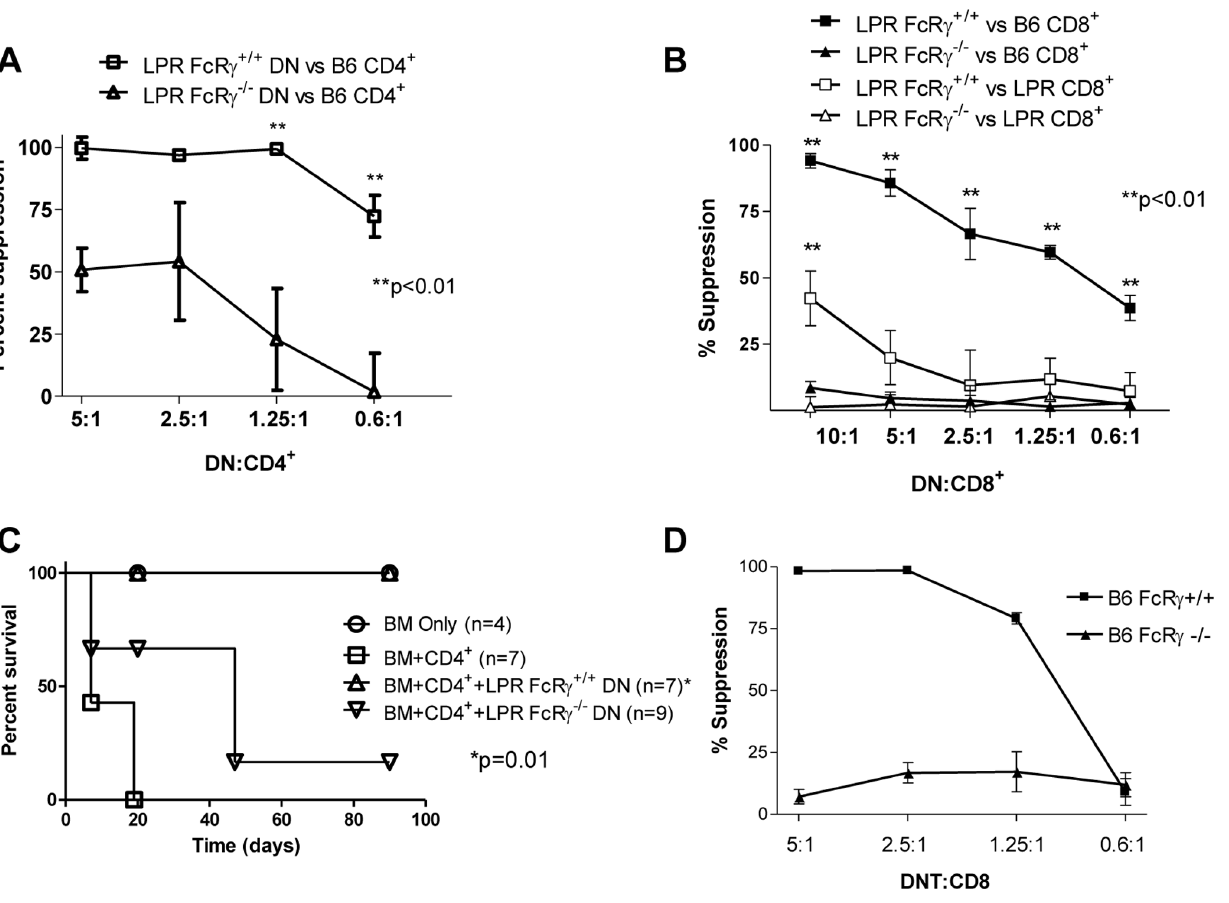
Figure 5. FcR c expression by LPR DN T cells is required for their regulatory function toward Fas-expressing syngeneic T cells. A. B6 CD4 + T cells (10 4 /well) were co-cultured with irradiated CB6F1 splenocytes (10 5 /well) and IL-2. Purified B6.LPR.FcR c + / + or B6.LPR.FcR c 2 / 2 DN T cells were added in varying ratios. After 4 days, 3 H-thymidine (1 m Ci/well) was added. After 18 h, 3 H-thymidine uptake was determined, and percent suppression was calculated. Two-way ANOVA p , 0.0001; Bonferroni post-tests **p , 0.01. Data are from one of three experiments with similar results. B. B6 or B6.LPR.FcR c + / + CD8 + T cells (10 4 /well) were cultured as in C. Percent suppression was calculated. Two-way ANOVA p , 0.0001 for the effect of FcR c on suppression of B6 CD8 + T cells; p=0.0043 for the effect of FcR c on suppression of B6.LPR CD8 + T cells. Bonferroni post-tests **p , 0.01. Data are from one of three experiments with similar results. C. Male CB6F1 mice were lethally irradiated and reconstituted with 2 6 10 6 TCD BM alone (BM Only) or with 10 6 B6 CD4 + T cells (BM + CD4 + ), with or without 5 6 10 6 B6.LPR.FcR c + / + or B6.LPR.FcR c 2 / 2 DN T cells. Mice losing . 25% of their body weight were sacrificed. *Log rank test p=0.01 for the comparison of mice treated with B6.LPR.FcR c + / + and B6.LPR.FcR c 2 / 2 DN T cells. Data are derived from two independent experiments, each with 2–5 mice per group. D. Naive B6 CD8 + T cells were used as responders and stimulated by irradiated bm1 splenocytes. Varying numbers of DN T cells isolated from spleens of bm1 splenocyte-treated B6.FcR c + / + (squares) or B6.FcR c 2 / 2 (triangles) mice were added to the MLR cultures as putative suppressor cells. Cell proliferation was measured by 3 H-thymidine incorporation. The data are expressed as percent inhibition of proliferation as compared with the controls to which no putative suppressor cells were added. Data points are the mean + / 2 SD of triplicate wells and are derived from one of three independent